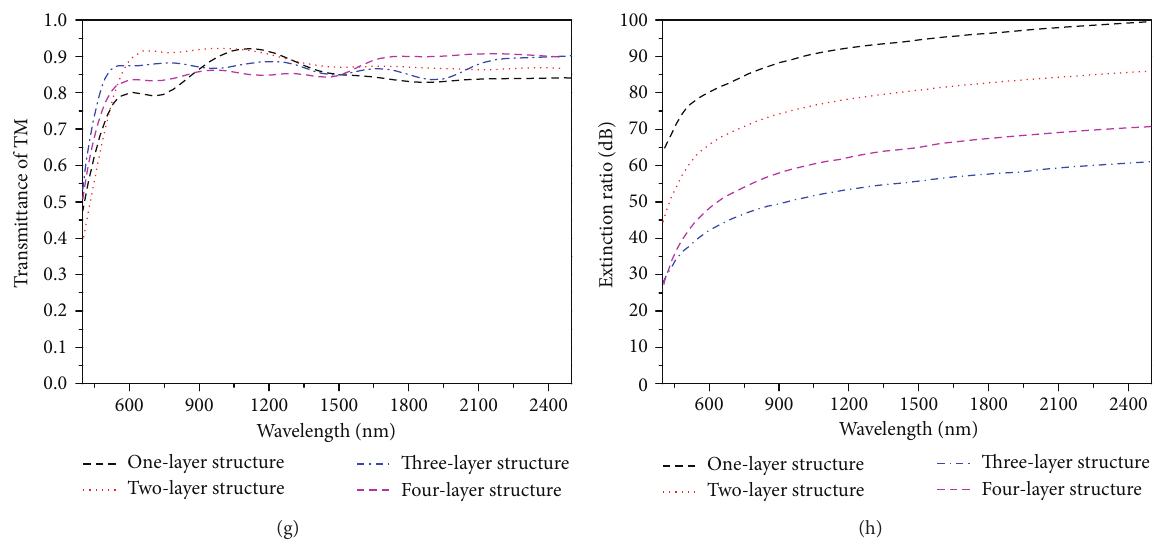
Figure 5: Relationship between groove depth and steps and the transmittance and extinction ratio as a function of wavelength ((a), (c), (e), and (g) stand for the transmittance of TM-polarization; (b), (d), (f), and (h) stand for extinction